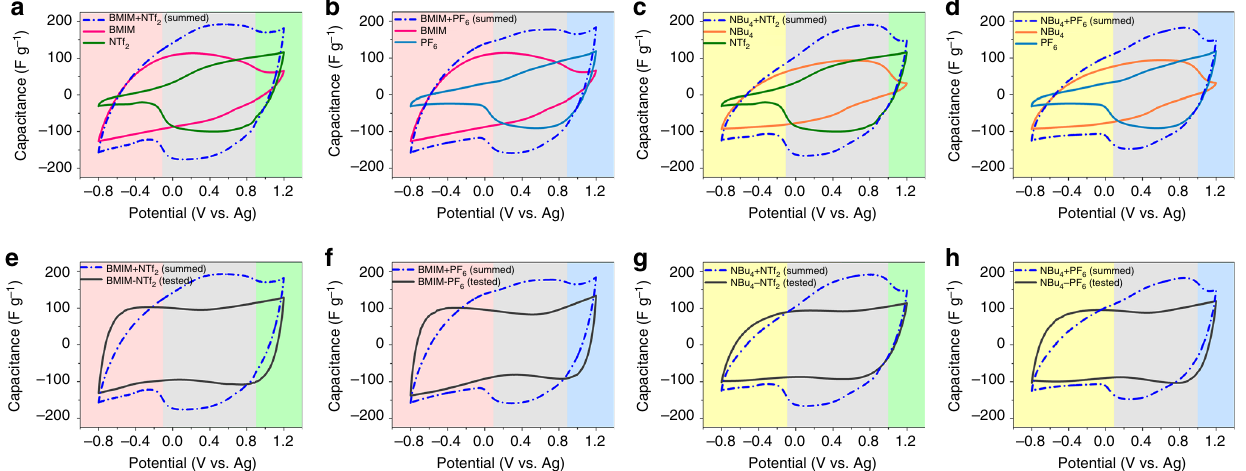
Fig. 4 Comparison of the summed CV curves with the real CV curves. Summed cyclic voltammetry (CV) curves of YP-50F electrode in four electrolytes by summing the CV curves of YP-50F electrode in four SiO 2 -grafted ILs shown in Fig. 3: a SiO 2 -IL-BMIM and SiO 2 -IL-NTf 2 , b SiO 2 -IL-BMIM and SiO 2 -IL-PF 6 , c SiO 2 -IL-NBu 4 and SiO 2 -IL-NTf 2 , d SiO 2 -IL-NBu 4 and SiO 2 -IL-PF 6 . Summed CV curves and real CV curves of YP-50F electrode in four corresponding conventional organic electrolytes: e